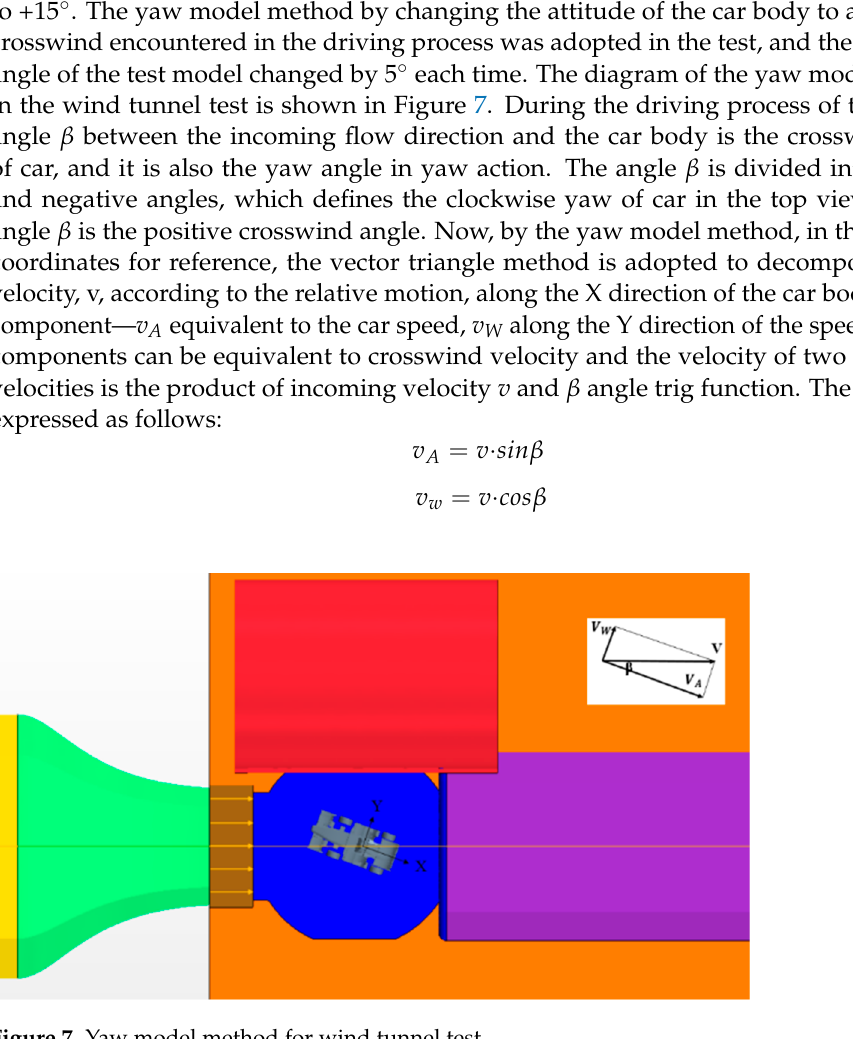
Figure 6. Lifting drag characteristic curve at 15–30 m/s wind velocity in straight-line condition.